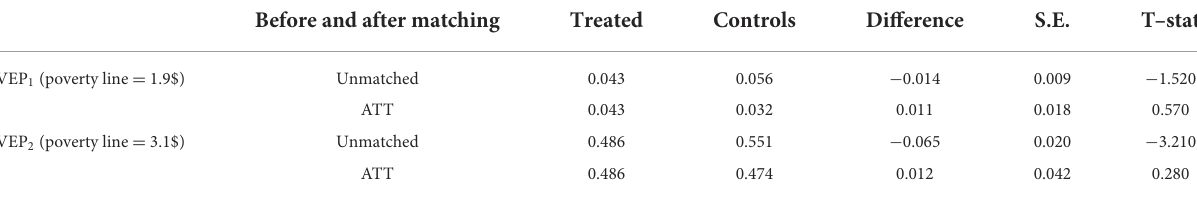
TABLE 4 The net effect of physical multimorbidity on poverty vulnerability [neighbor (K = 1)]. Before and after matching Treated